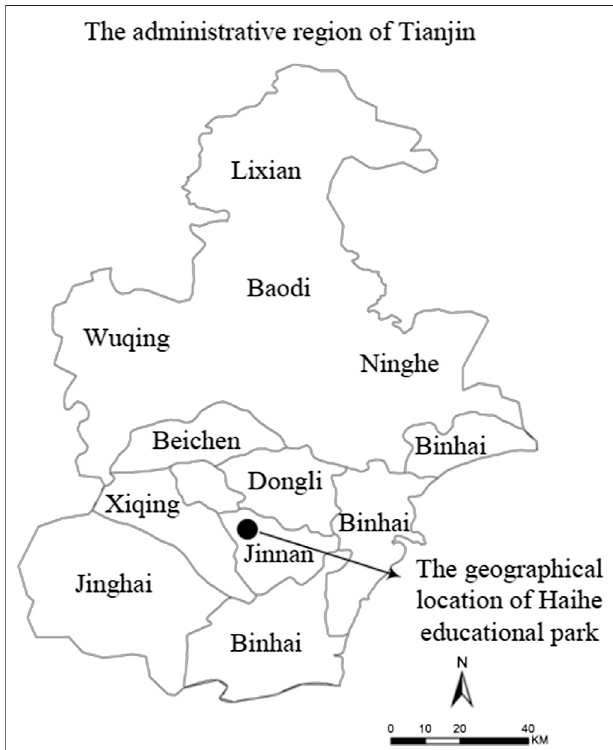
FIGURE 2 | Demonstration of study area.